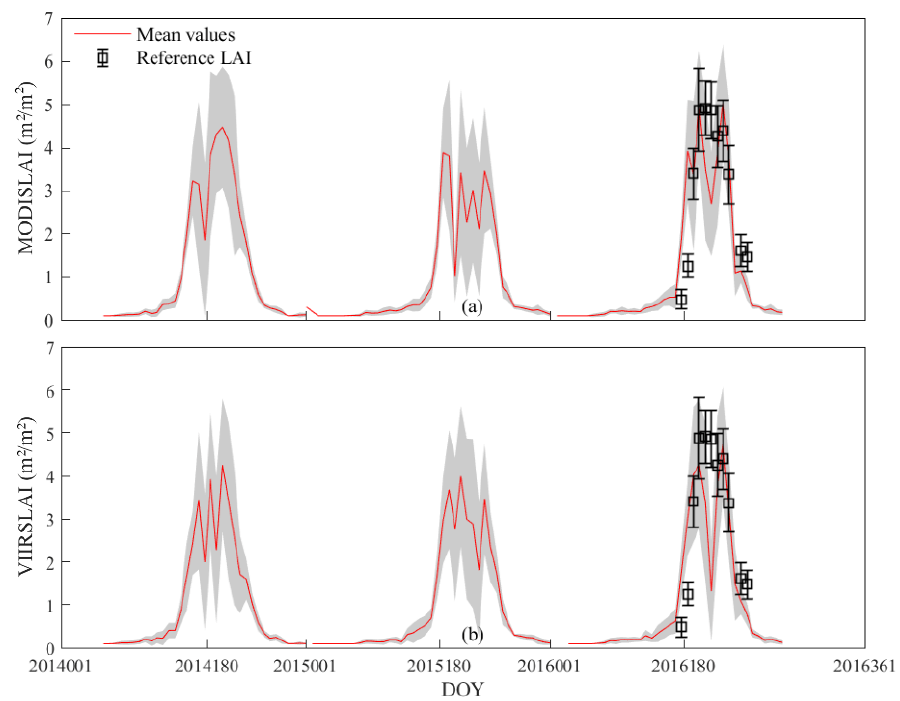
Figure 6. Time-series variations in MODIS ( a ) and VIIRS ( b ) LAIs during 2014 – 2016. The red line represents the average values of all available pixels, and the gray area stands for ± one standard deviation.